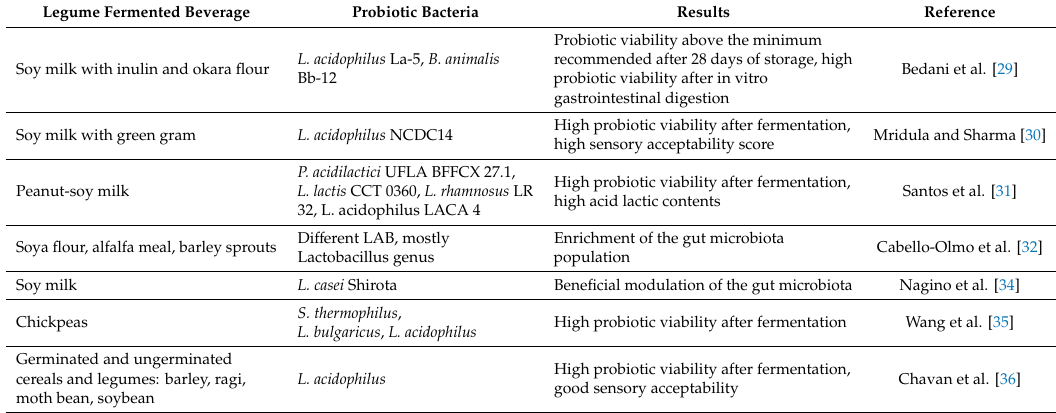
Table 1. Summary of fermented legume beverages as potential carriers for bioactive compound, probiotic, and prebiotic delivery to the